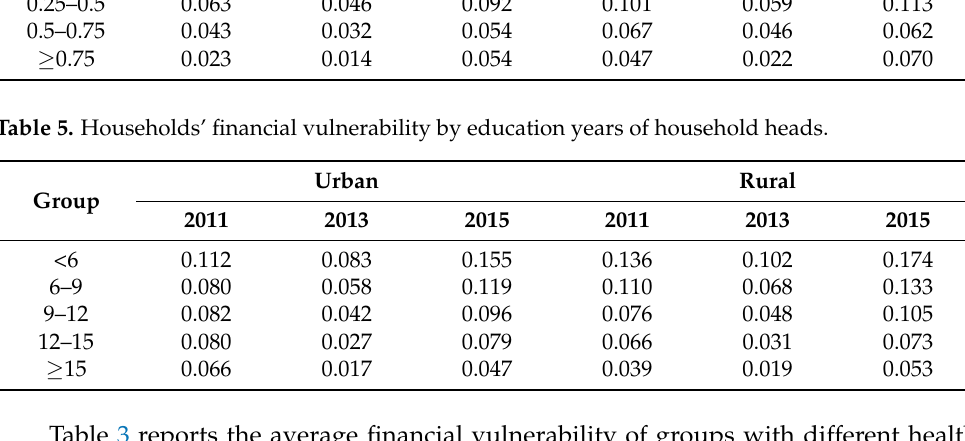
Table 4. Households’ financial vulnerability by labor force proportion of households. Group <0.25